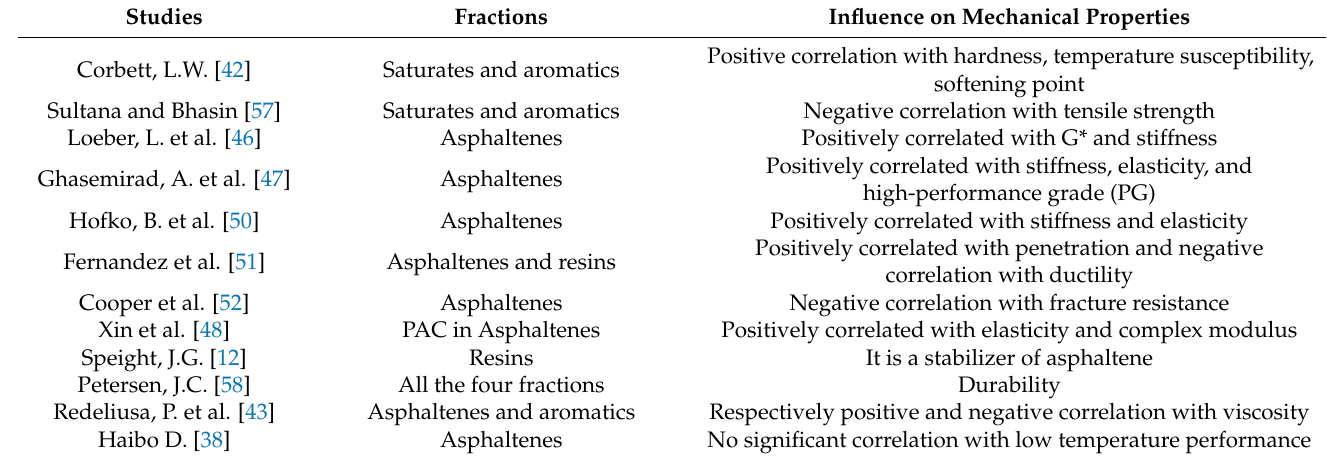
Table 1. Effect of fractions on mechanical properties of asphalt in previous